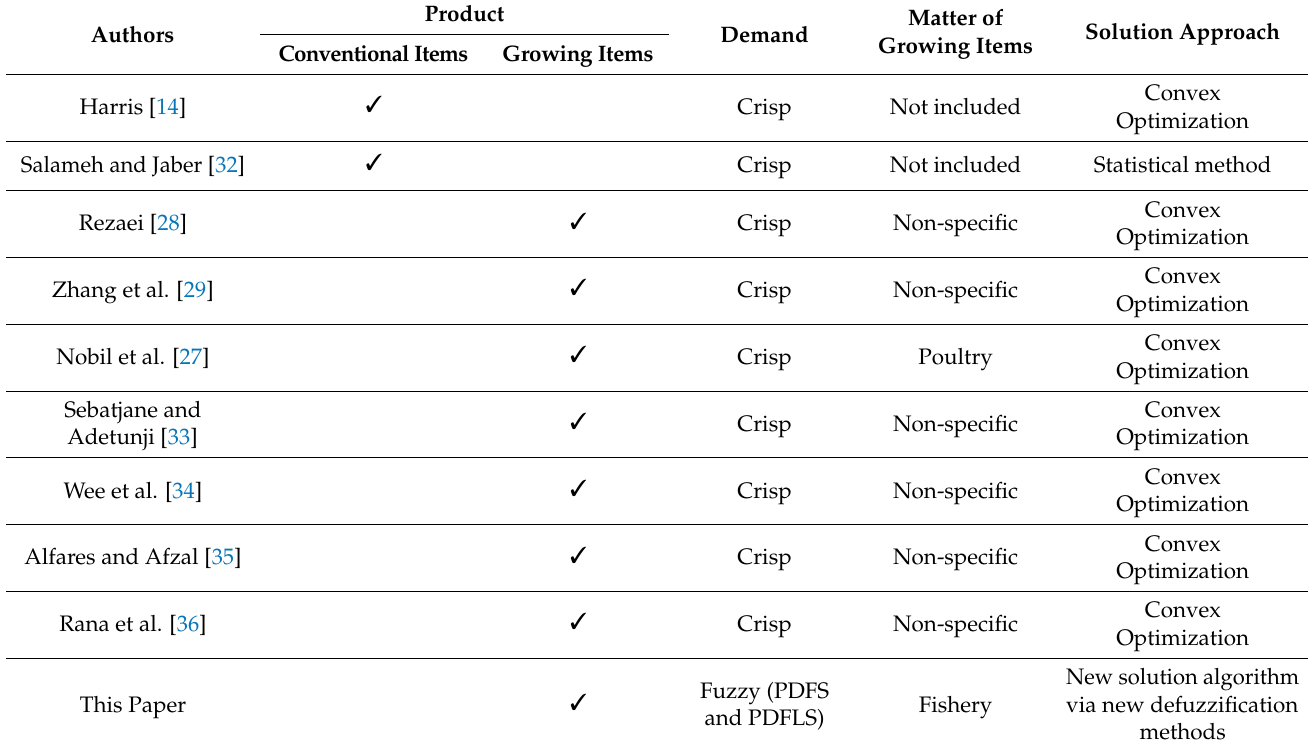
Table 1. Literature review of recent major studies of growing items